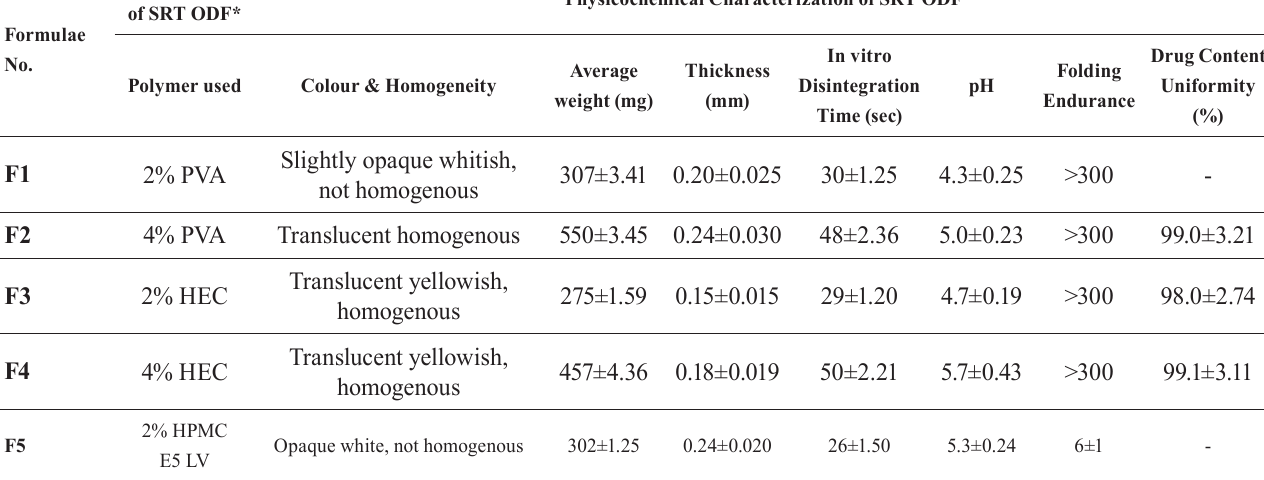
TABLE I - C omposition and physicochemical characterization of SRT ODFs